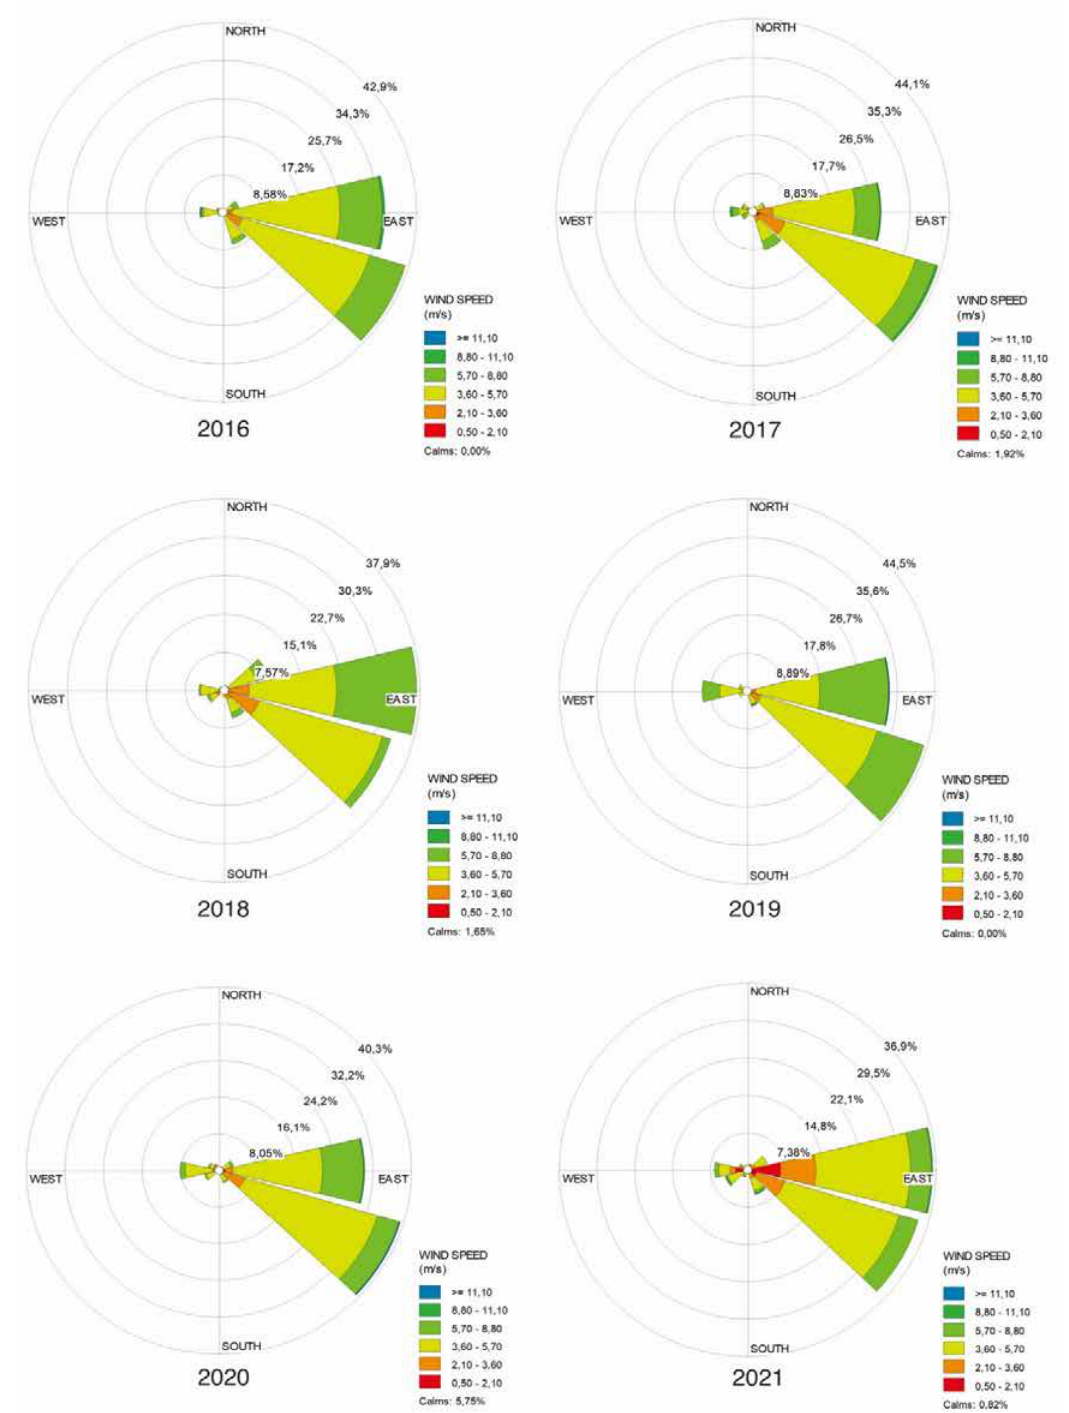
Fig. 2: Annual wind condition around the cement plant complex in 2016 – 2021